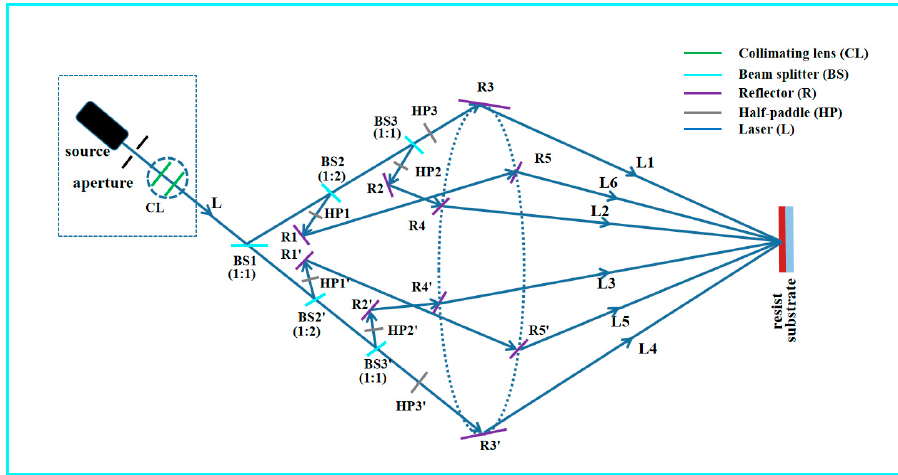
Figure 1. Schematic of a six-beam laser interference lithography (LIL) system for fabricating micro- structures.